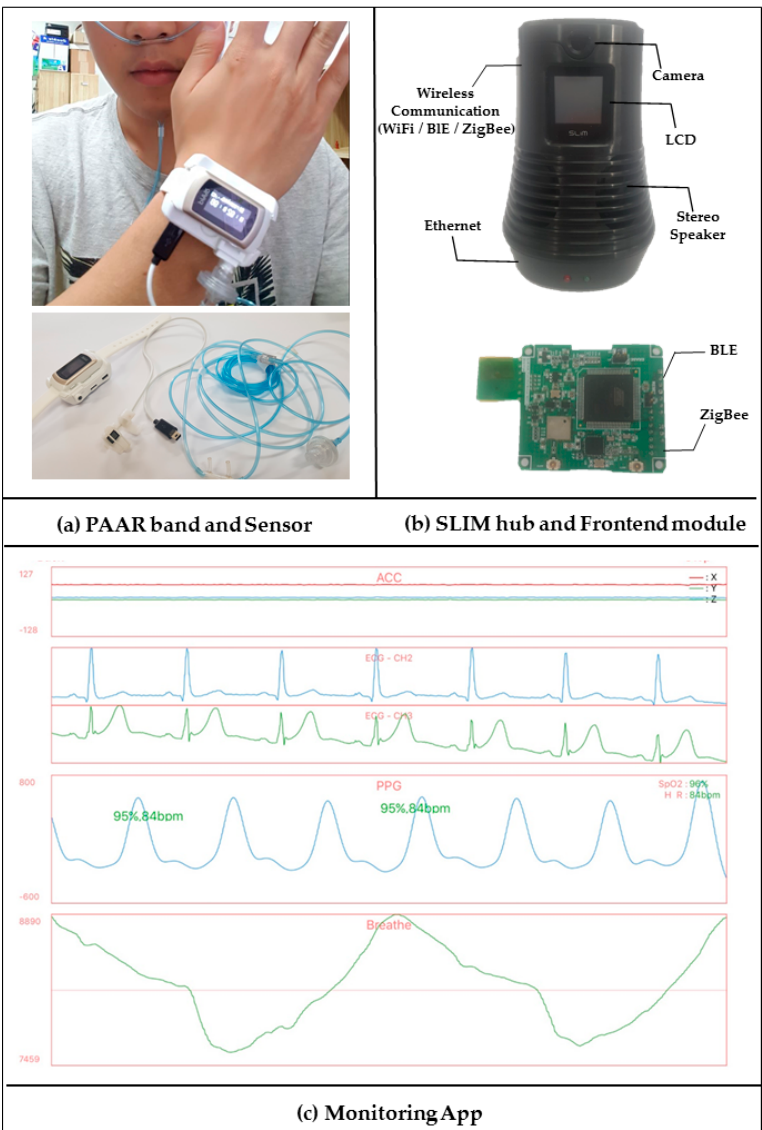
Figure 15. Hardware modules used in experiments. ( a ) PAAR band and Bio-signal measurement sensor; ( b ) SLIM hub and Frontend module; ( c ) Monitoring App.